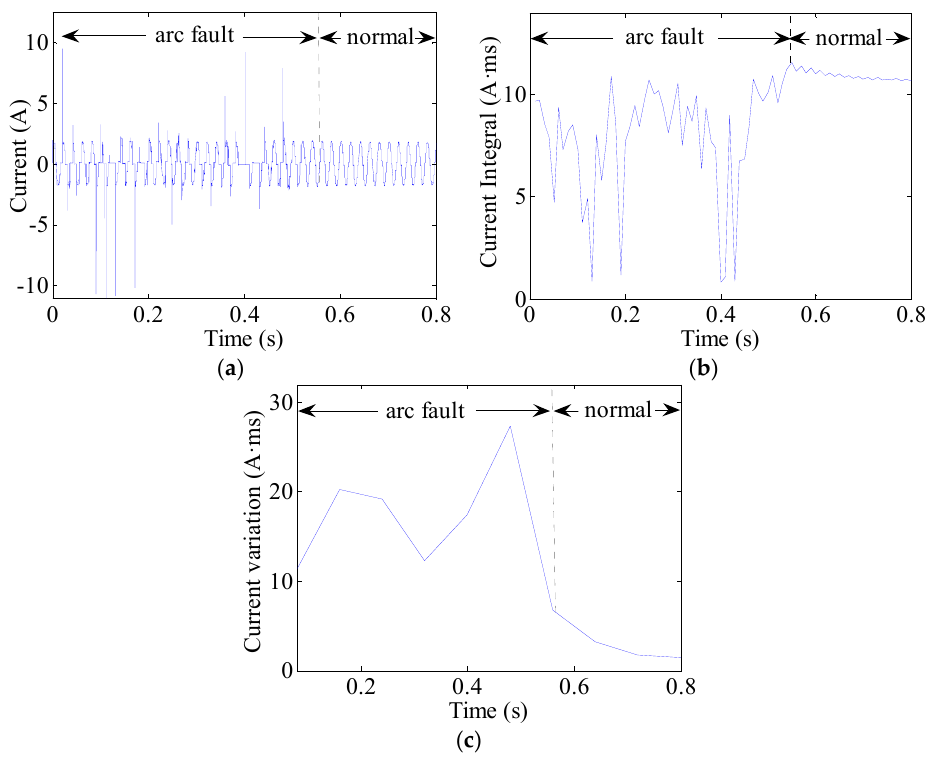
Figure 15. Arc fault current analysis of the halogen lamps: ( a ) current waves; ( b ) current periodic integrals; ( c ) current variations.